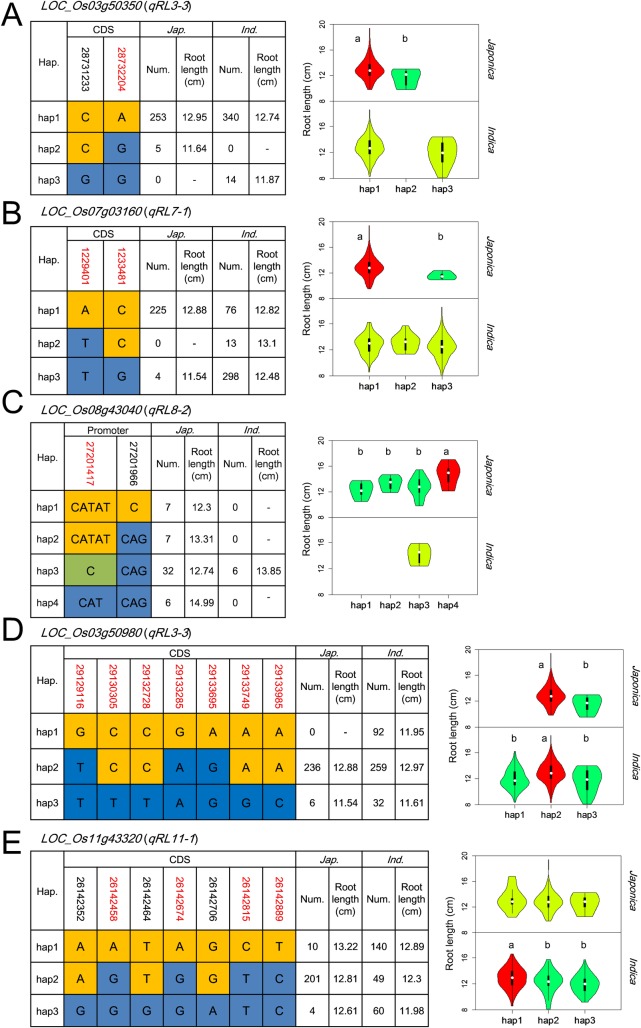
Haplotype analyses of five QTL genes for root length.Gene structures (left) and root lengths of different haplotypes (right) of (A) OsRL3.3 (LOC_Os03g50350) for qRL3-3, (B) OsSIZ2 (LOC_Os03g50980) for qRL3-3, (C) OsRL7.1 (LOC_Os07g03160) for qRL7-1, (D) OsRL11.1 (LOC_Os11g43320) for qRL11-1, (E) OsRL8.2 (LOC_Os08g43040) for qRL8-2, where red colored numbers show the key positions where amino acid substitutions occurred among major haplotypes, that resulted in significant differences in root length; among violin maps of different haplotypes in subpopulations japonica (upper right) and indica (lower right), different letters above the violins indicate significant differences (P < 0.05) when analyzed by Duncan’s test or independent-sample t-tests.